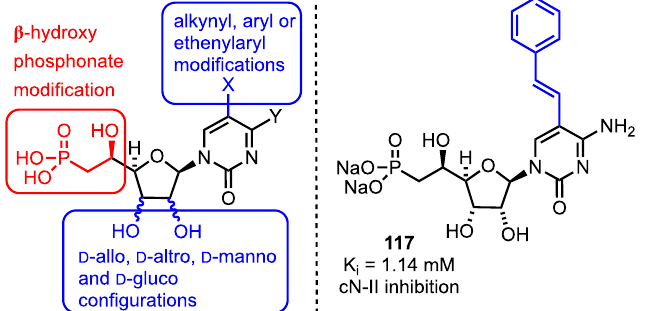
Figure 9. 5’- β -Hydroxyphosphonate analogues developed by Peyrottes and active compound 117 from this series, Y = NH 2 or OH.